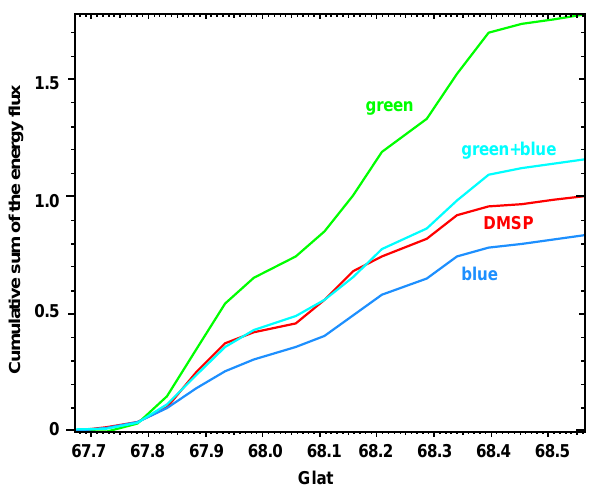
Fig. 5. Cumulative sum of the energy fluxes from green (green curve), blue (blue curve) and green plus blue (turquoise curve) ASC images compared to the measured flux from DMSP (red curve). All sums are normalised so that the total energy flux measured by the satellite is one.